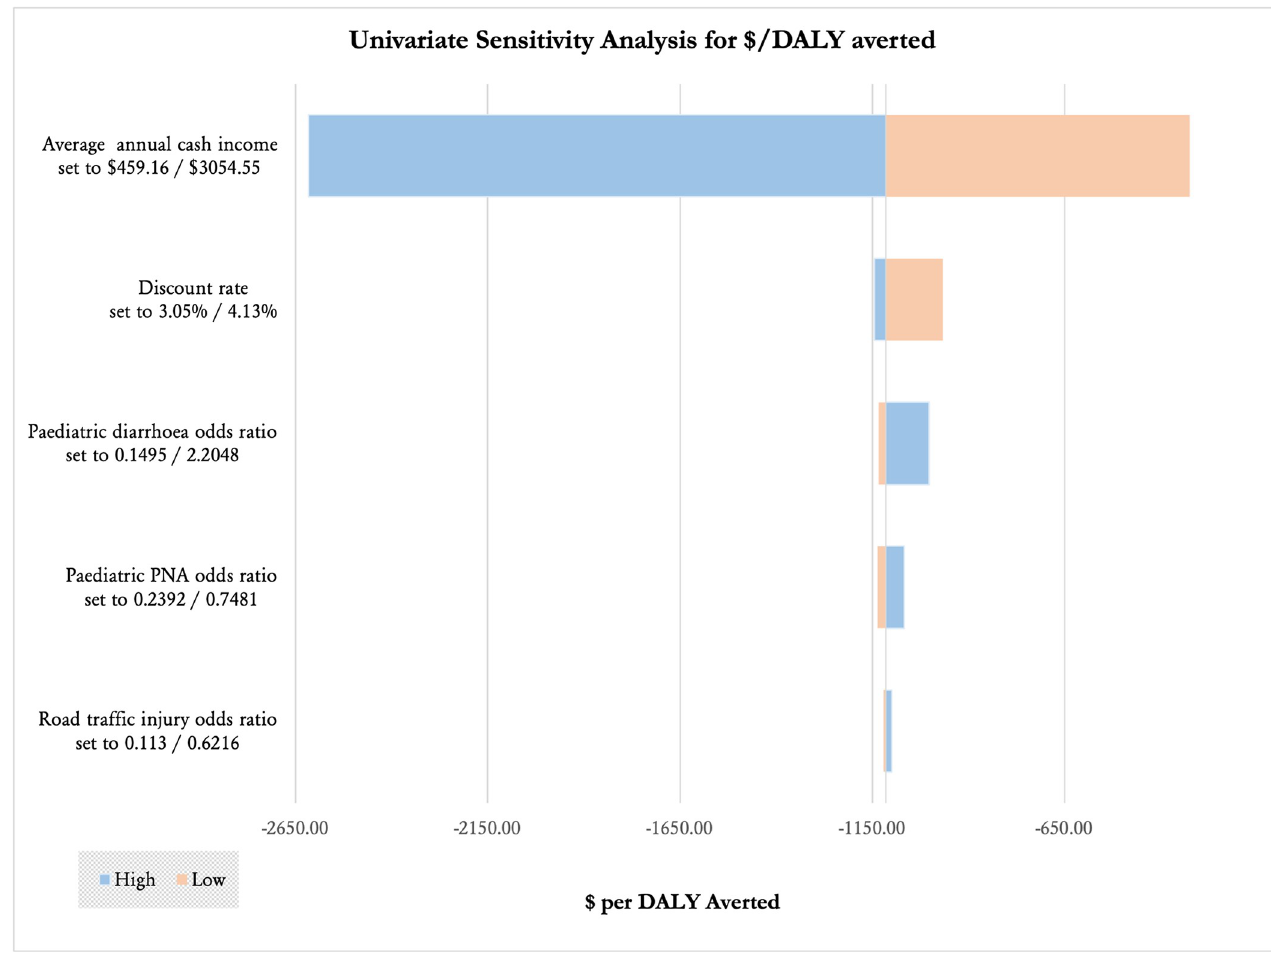
Fig 2. Results of a univariate sensitivity analysis of key variables on cost per DALY